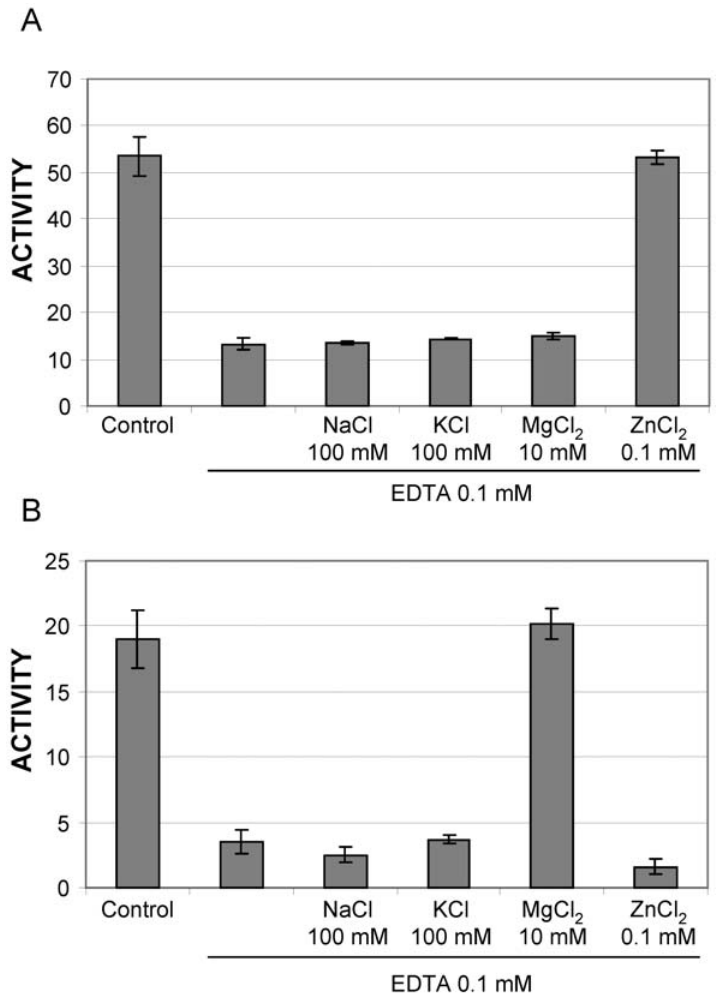
Figure 6. Effect of EDTA and metal ions on wALAD and hALAD enzyme activities. A) wALAD and B) hALAD were assayed at pH 8.0 and 7.0, respectively. Conventional concentrations of metal ions were used in this assay. The enzyme activity is expressed as m mol PBG/mg of protein/h. Control indicates sample without addition of extra metal ions or EDTA.